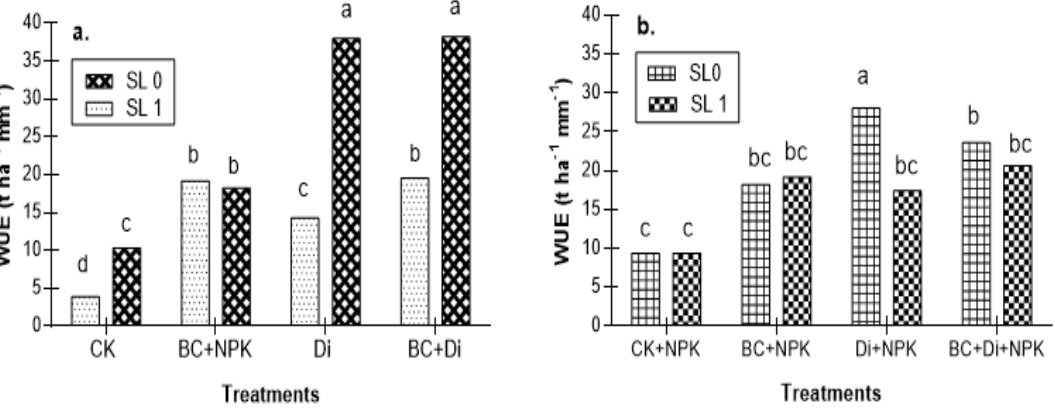
Figure 4. Effect of biochar and digestate treatments on water use efficiency (WUE) (( a ) Without NPK and ( b ) With NPK fertilizer) under different saline water treatments (SL0 and SL1).